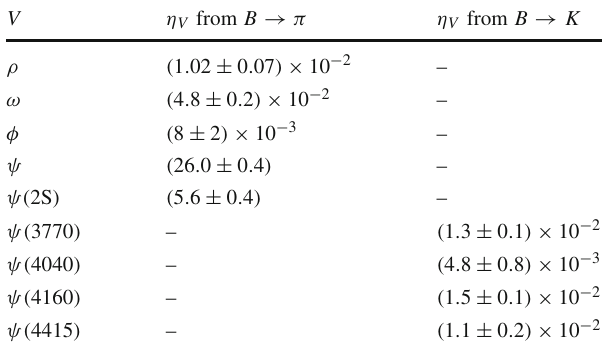
Table 2 Numerical results for the moduli of the η V parameters control- ling long-distance effects in B + → π + (cid:3) + (cid:3) − . The uncertainties include onlytheexperimentalerrorsonthe B ( B + → π + V ) and B ( V → e + e − ) values used to determine a given η